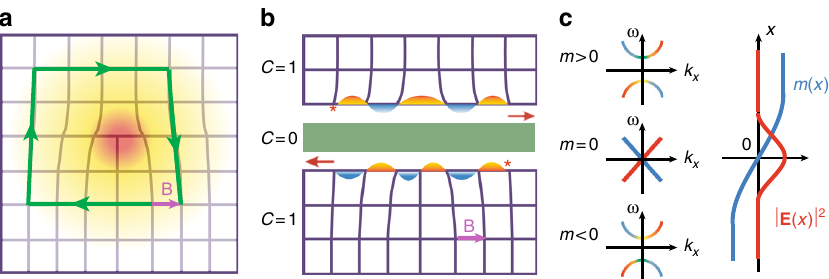
Fig. 1 Light-trapping on a dislocation due to dual-topology. a Schematic of a dislocation and the Burgers vector in a rectangular lattice. A photonic-bound state (red region) is localized at the center of the dislocation. b Illustration of the cut-and-glue technique. Inserting a chunk of photonic crystal with trivial topology (the green strip) into a topological PhC with a dislocation yields two edge channels at opposite boundaries. Because of the additional lattice period in the lower edge, on the left (right) side of the dislocation there is a π (no) phase difference between the two edge states. c The π phase shift in the edge channels yields a sign-change in the Dirac mass across the dislocation, forming a Dirac mass domain-wall which results in a photonic Jackiw – Rebbi